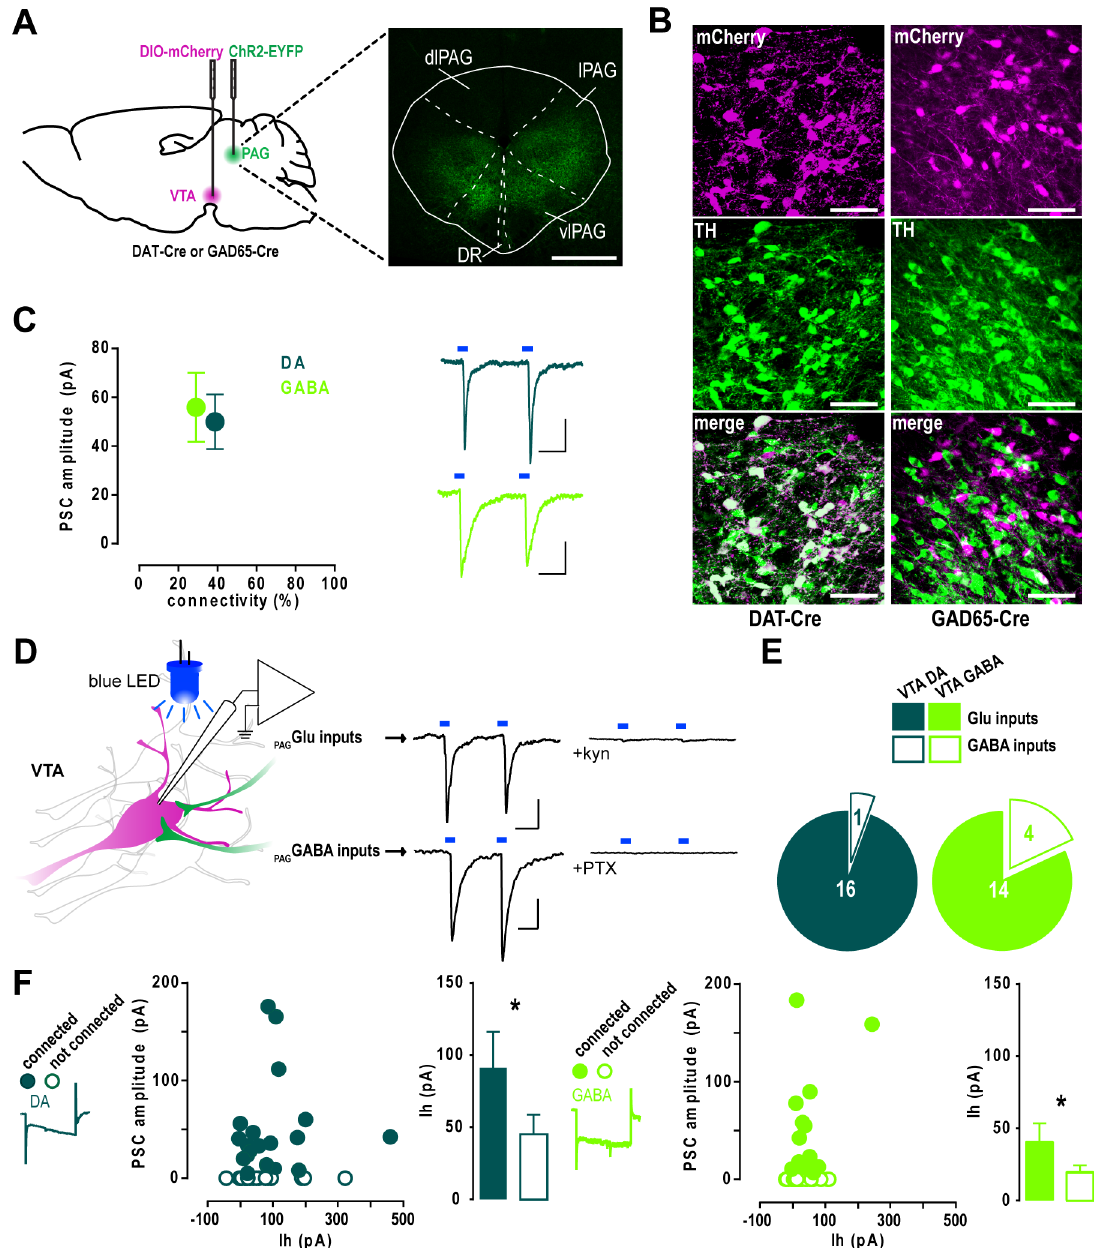
Fig 2. PAG afferents equally target VTA DA and GABA neurons. A, Left, schematic of the injectionprotocolfor patch clamp experiments. Right, exampleof image of ChR2-EYFPinfectionin the PAG. Scale bar, 500 μ m. B, High magnification confocalimages showingthe colocalization or exclusionof mCherry and TH in DAT-Cre or GAD65-Cre mice, respectively. Scale bars, 50 μ m. C, Mean amplitudeof the light-evoked postsynapticcurrents in VTA DA ( n = 47) and GABA ( n = 62) neuronsplotted against the percentageof connected neurons(Mann Whitney U test: no difference in amplitudes, p > 0.05; Fisher’s exact test: no difference in connectivity, p > 0.05). Scale bars, 20 ms, 20 pA. D, Left, schematic of the patch clamp experiments: whole-cellrecordings were performed from mCherry-expressingVTA neuronswhile PAG afferents inputs were light-stimulated (left). Right, excitatory currents were blockedwith kynurenicacid (kyn), while kyn-resistant inhibitorycurrents were blocked with picrotoxin(PTX). Scale bars, 20 ms, 20 pA. E, Proportionof kyn-sensitiveglutamateinputs and PTX- sensitive GABA inputs in VTA DA ( n = 17) and GABA ( n = 18) neurons(Fisher’s exact test: no difference between cell types, p > 0.05). F, Mean light-evoked current amplitudeplotted against I h amplitude(Spearman’s rank correlation: no correlation betweenthe variables, r = 0.2702, p > 0.05) and comparisonof I h betweenconnectedand non-connected VTA DA (left) or GABA neurons(right) (Mann Whitney U test: * p <